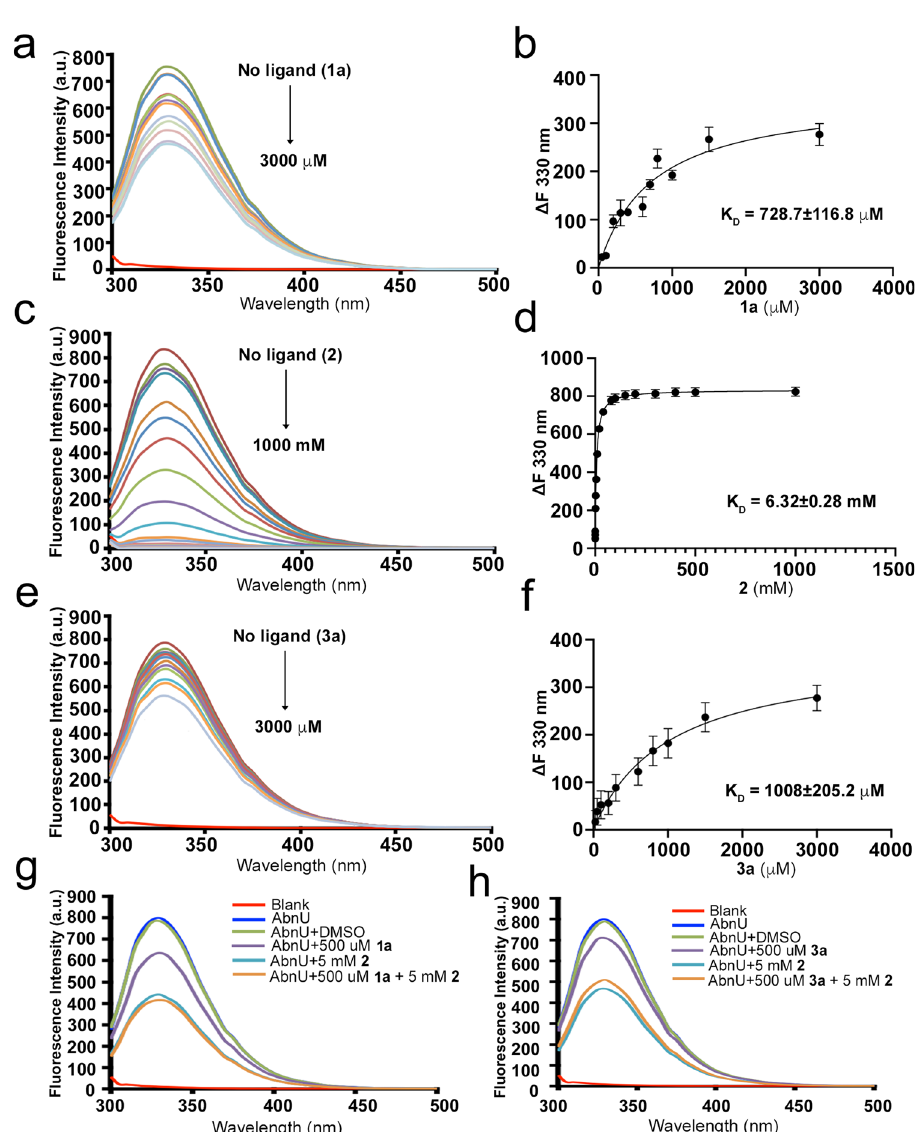
Fig. 5 Intrinsic tryptophan fl uorescence study of AbnU contributed by W114 residue. AbnU is titrated with increasing concentrations of 1a ( a ), 2 ( c ) and 3a ( e ) and the intensity was measured between 300 and 500 nm wavelength. Excitation was carried out at 285 nm. Fluorescence maxima were observed at 330 nm. Fluorescence quenching of tryptophan is noted with increasing concentrations of ligands. ( b ), ( d ) and ( f ) depict the AbnU — ligand af fi nity ( K D ) calculated using the one-site-speci fi c binding model 32 . g Monitoring of tryptophan fl uorescence of AbnU with 1a (purple), 2 (cyan) and combination of